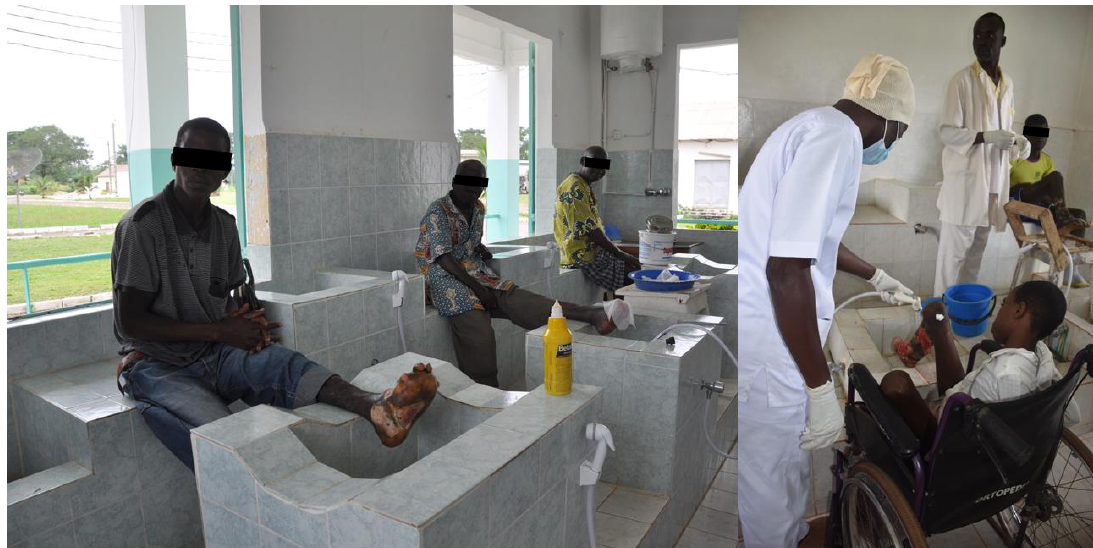
Figure 2. Wound care facility in Côte d’Ivoire for leprosy, Buruli ulcer, and other ulcers.